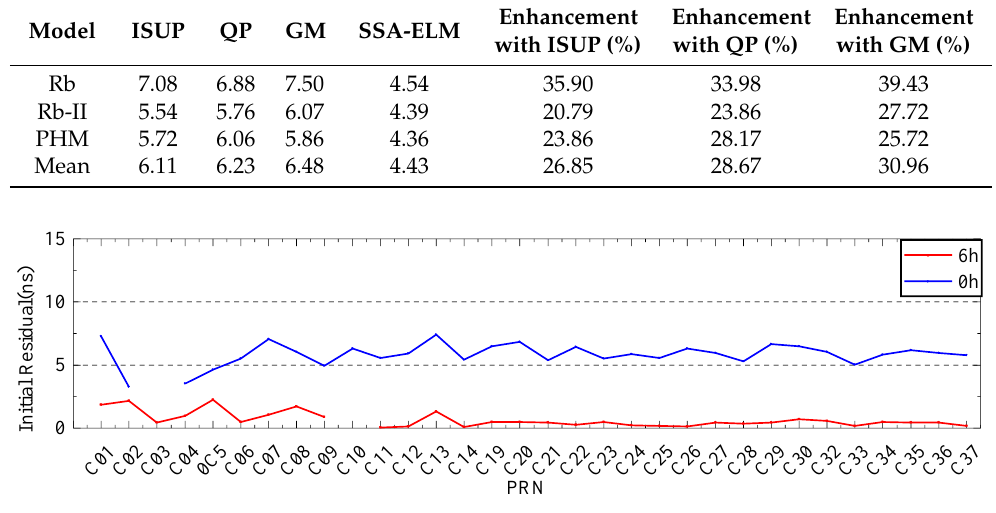
Table 10. The average RMS values of 6 days for three different prediction models (ns).